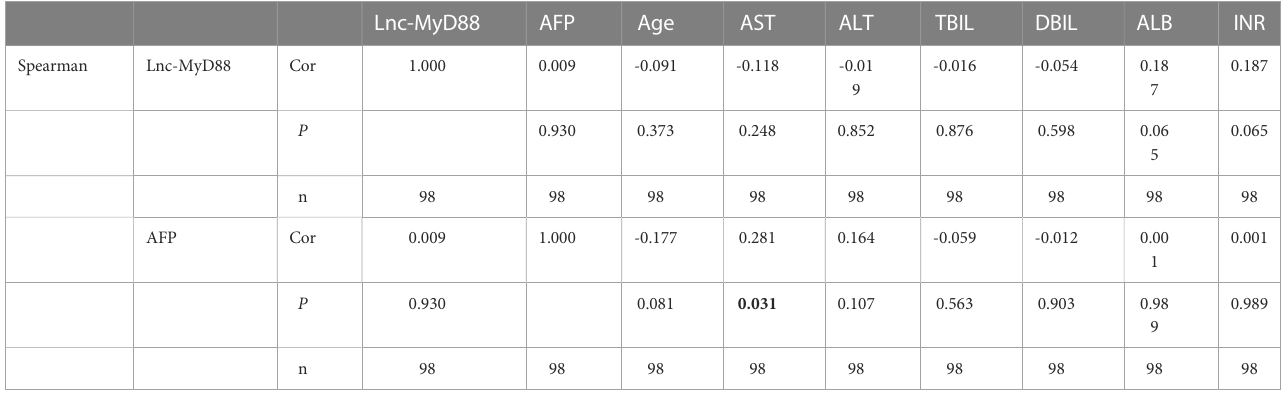
TABLE 5 The correlation analysis of lnc-MyD88 and other testing indexes.